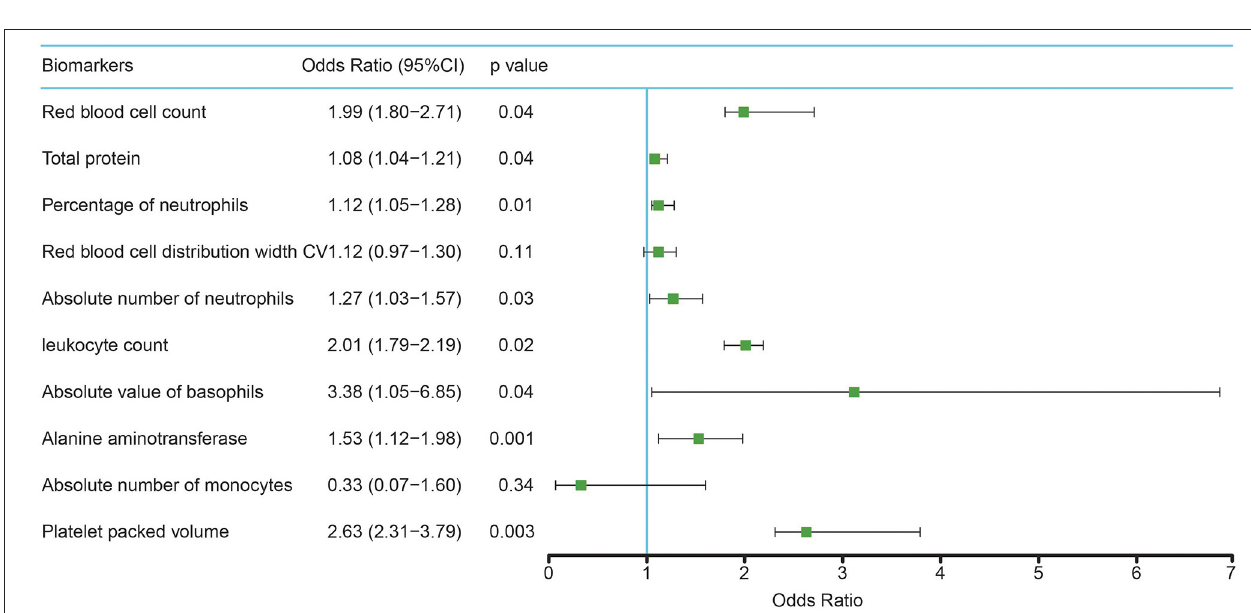
FIGURE 4 | Nomogram for the prediction of MS with Lasso selected